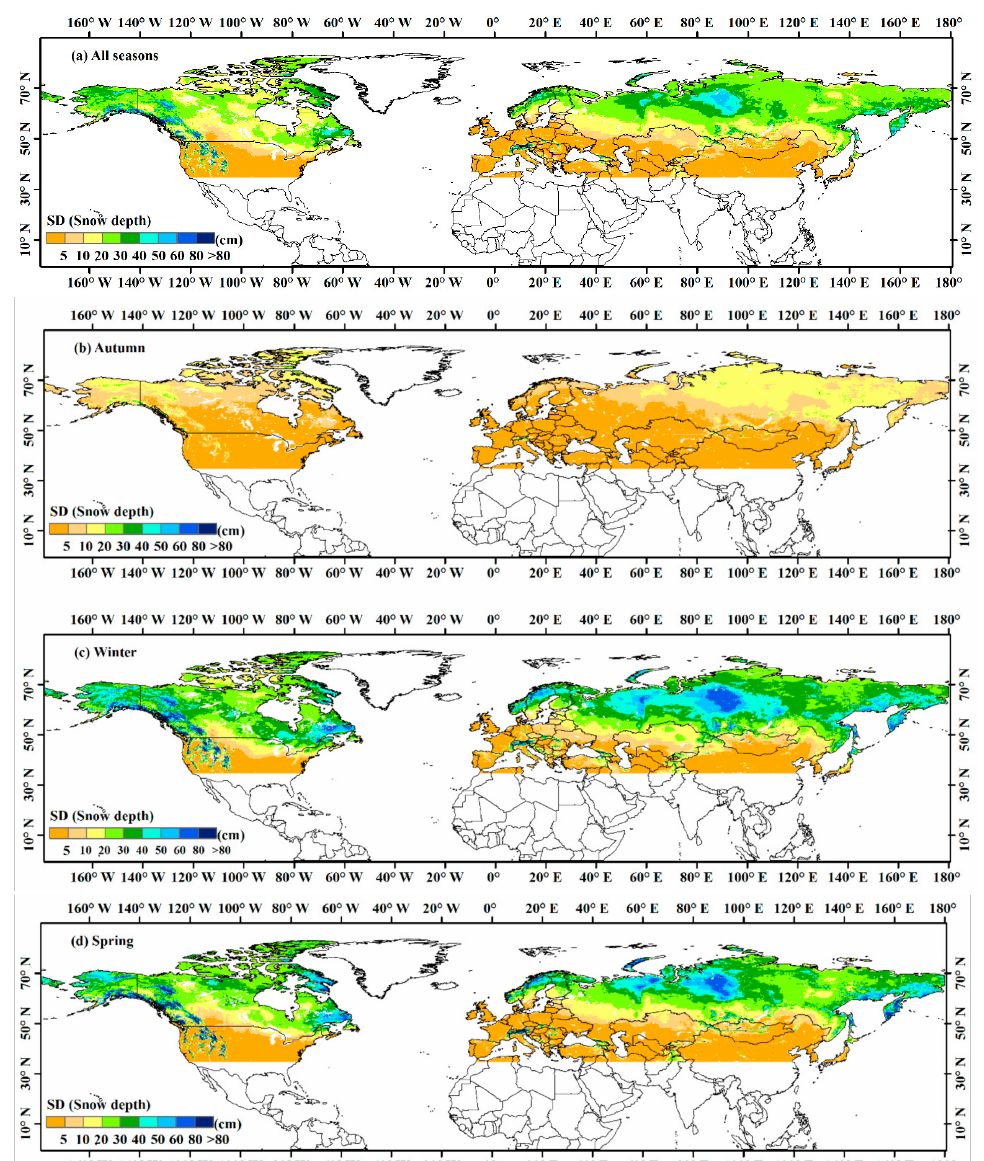
Figure 8. The spatial patterns of the fused snow depth based on the Random Forest Regression (RFR) algorithm across the Northern Hemisphere between 2002 to 2011. ( a ) Average snow depth in all seasons, ( b ) Autumn (September to November) average snow depth, ( c ) Winter (December to February), and ( d ) Spring (March to May) average snow depth.